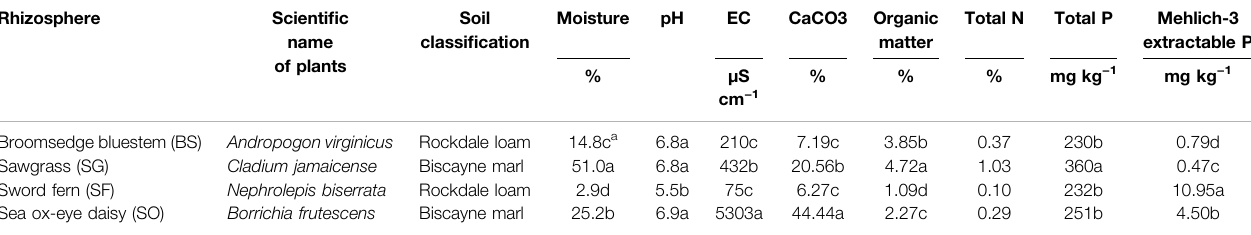
TABLE 1 | Basic characteristics of soils collected from rhizospheres of native plants including bluestem (BS), sawgrass (SG), sword fern (SF), and sea ox-eye daisy (SO) in Miami-Dade County, Florida. Rhizosphere